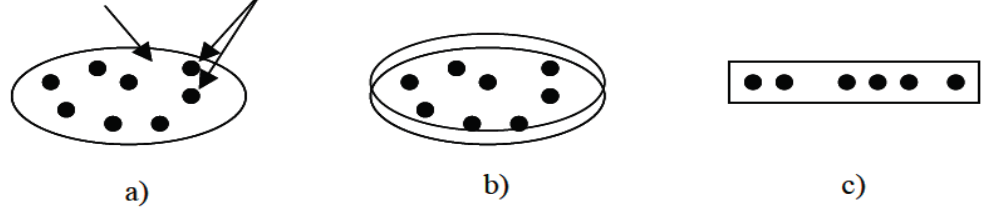
Figure 2. Three steps of sandwich preparation for the